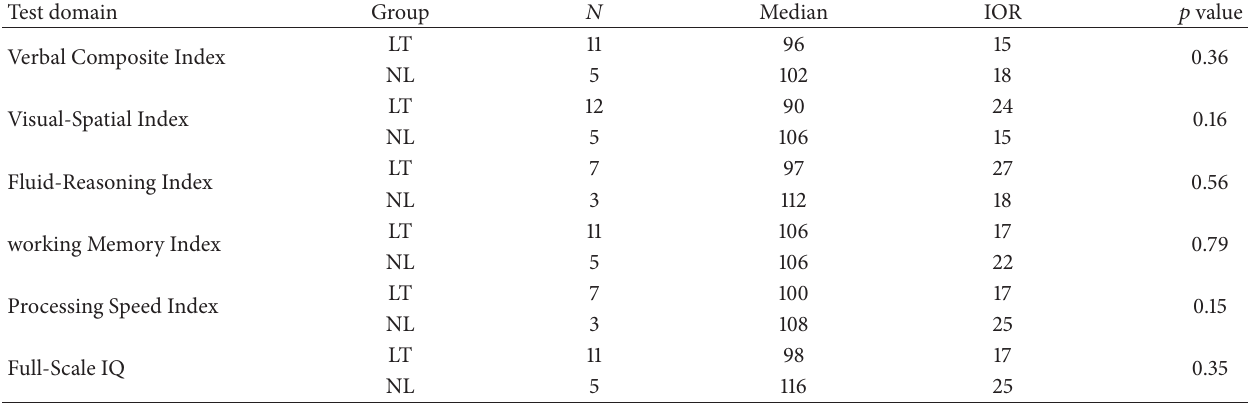
Table 2: Cognitive task results, WPPSI-IV.